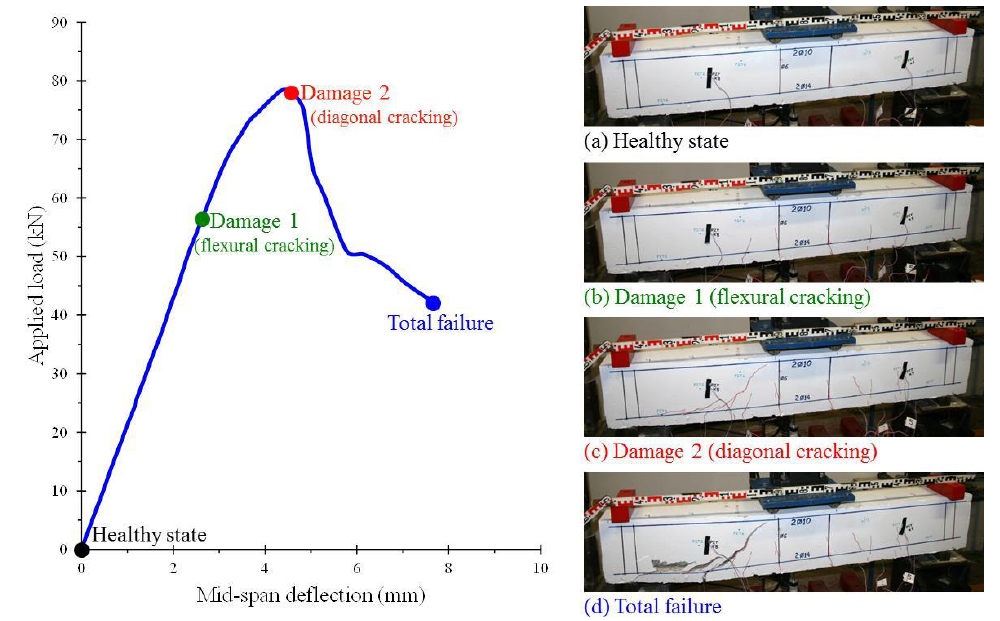
Figure 5. Experimental shear response and cracking patterns at different damage - loading levels of the tested RC beam